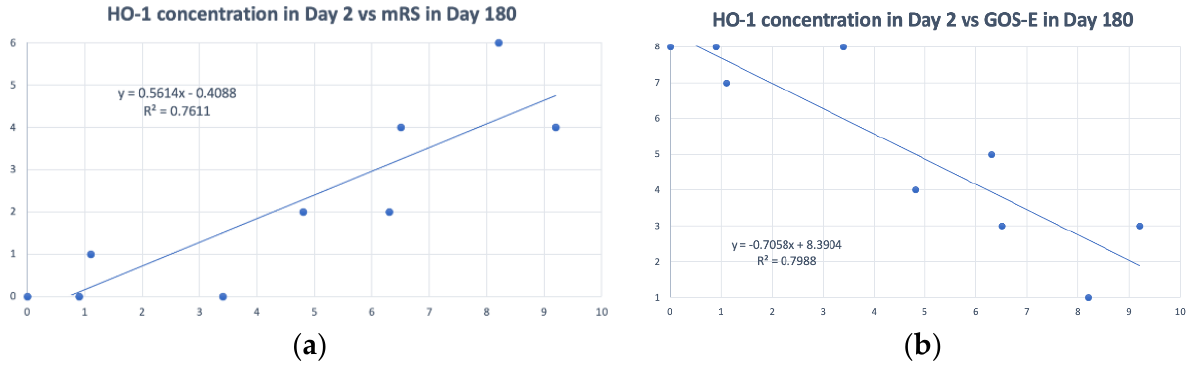
Figure 6. ( a ) Heme oxygenase (HO)-1 concentration on day 2 correlated with the modified Rankin Scale (mRS) on day 180. ( x -axis: HO-1 concentration in cerebrospinal fluid (CSF) (ng/mL) y -axis: mRS from 0 to 6) ( b ) HO-1 concentration on day 2 correlated with the Glasgow Outcome Scale-Extended (GOS-E) on day 180. ( x -axis: HO-1 concentration in CSF (ng/mL); y -axis: GOS-E from 1 to 8). (Data from ELISA).